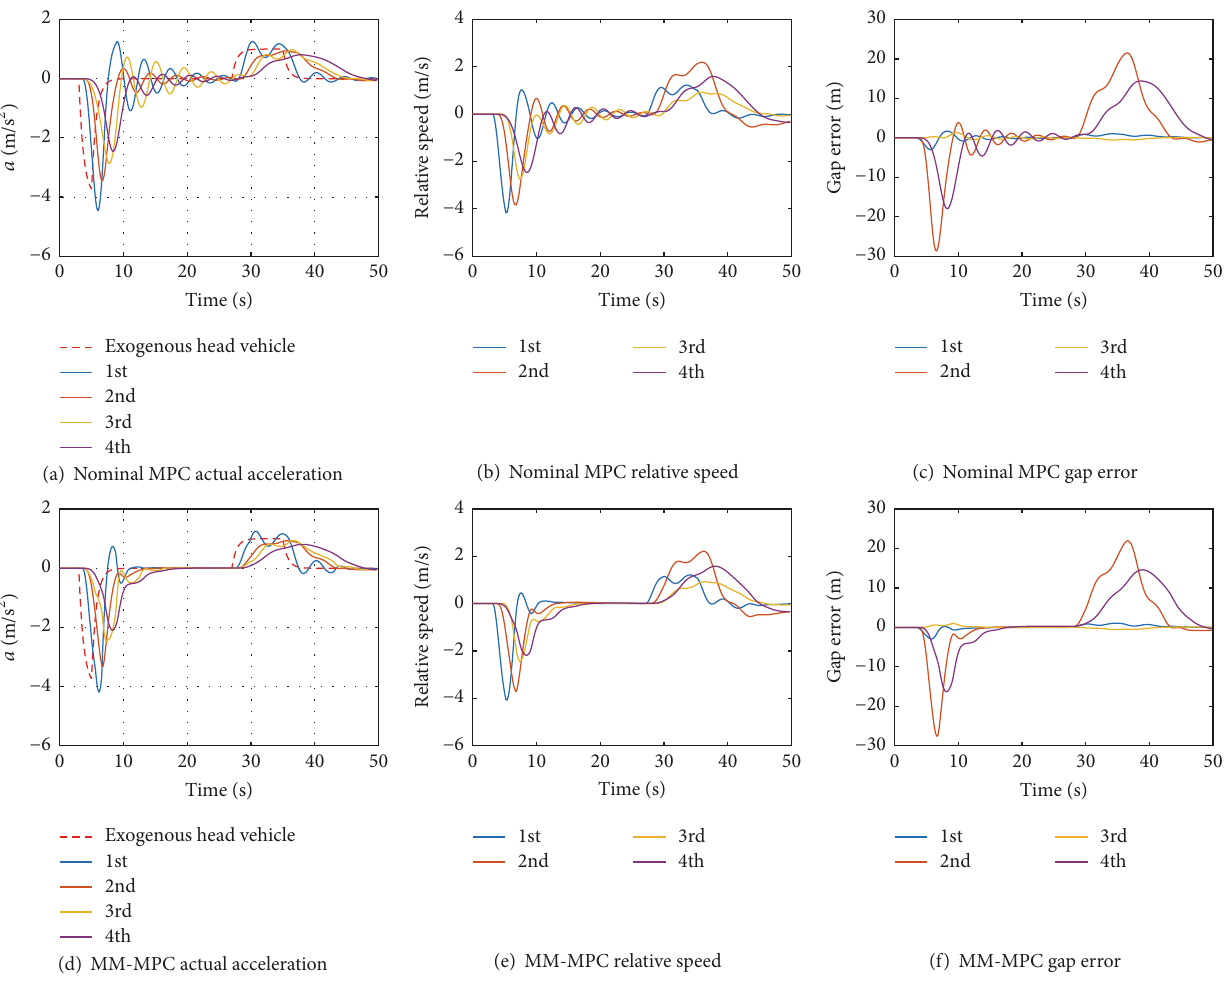
Figure 5: Comparison of nominal MPC ( 𝜏 𝐴 = 0.2 s) and MM-MPC (designed with 𝜏 𝐴 (𝑡) ∈ [0.2,0.8] s) for heterogeneous platooning control while actual 𝜏 𝐴 (𝑡) ∈ [0.8, 0.9] s. Table 4: Performance results: heterogeneous platooning